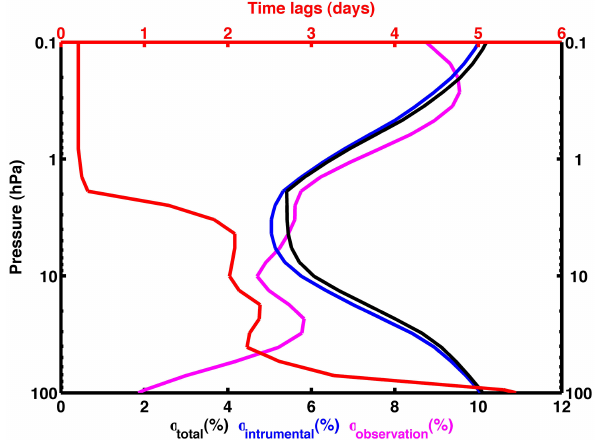
Figure 8. Uncertainty budget of GROMOS used in the trend analy- sis. The red line is an example of monthly mean correlation length profile, in units of days, calculated for the time interval from Octo- ber 2011 to October 2014. The magenta line is the monthly mean observation error profile, calculated for the same time interval. The blue line is the estimated instrumental error profile. And the black line represents the total contribution of the uncertainty of GRO-